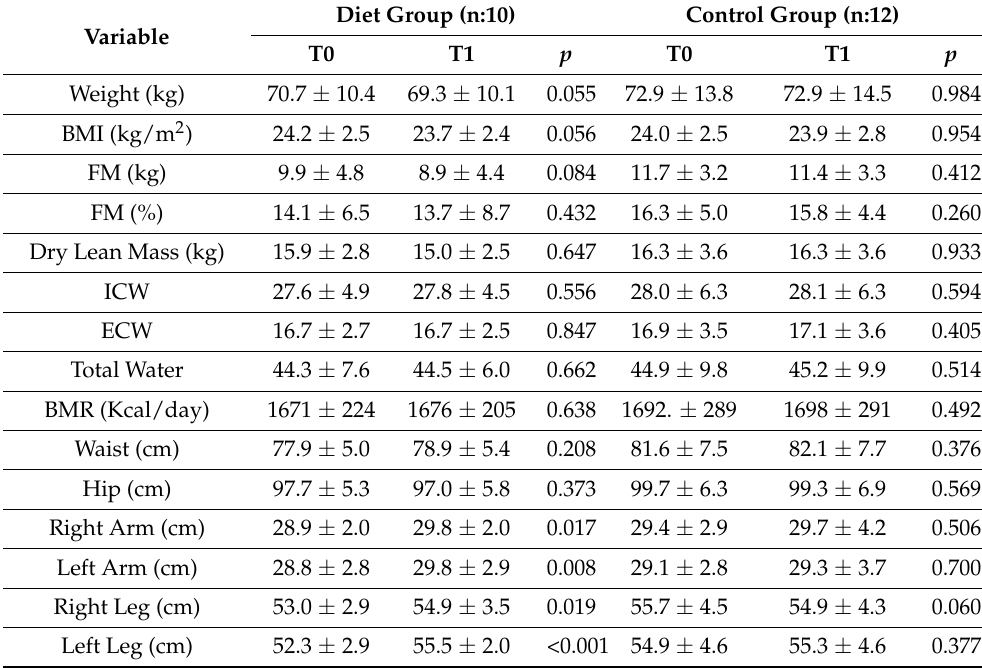
Table 2. Body composition and circumferences in the diet and control group before and after the intervention.